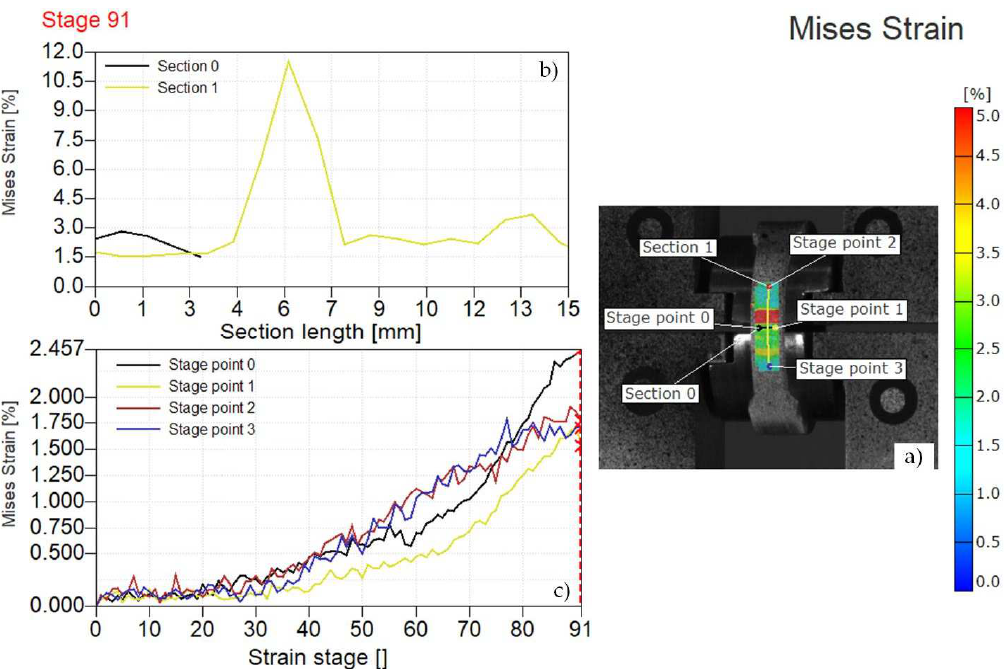
Figure 6. Visualization of von Mises strain field before fracture for Single PRTS specimen with 90% infill: ( a ) visualization of von Mises strain field at the stage just before fracture; ( b ) von Mises strain value with respect to the section length; ( c ) von Mises strain value change over time.